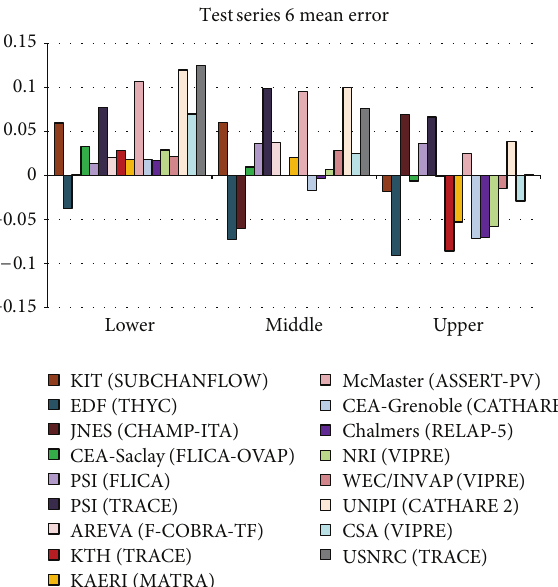
Figure 23: Test series 5 void fraction mean error.